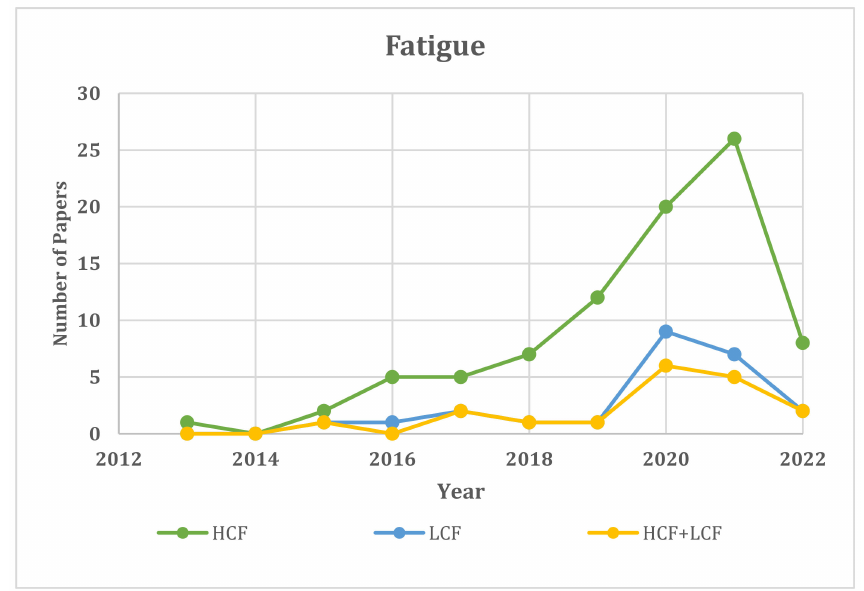
Figure 7. Fatigue